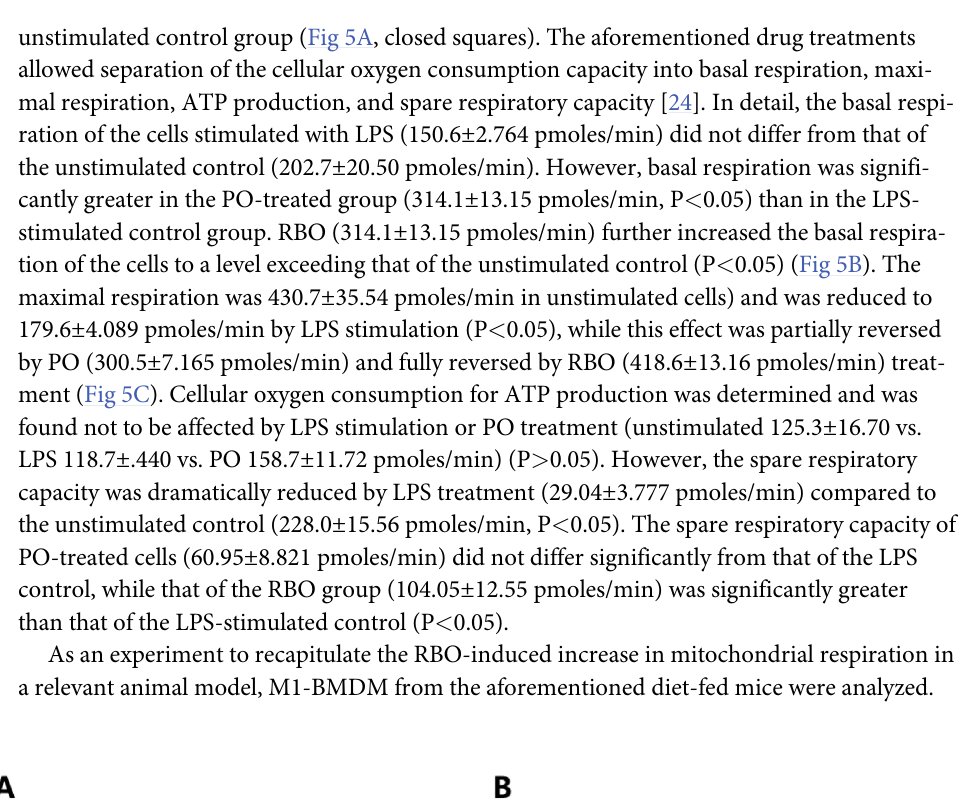
Fig 2. Cytokine production by M1-polarized BMDM following dietary intervention with an AIN-76A-based diet containing either CO, PO, or RBO for 4 wks. Data are presented as mean ± SEM (n = 7–8). Values with different letters are statistically significant at p < 0.05 within the panel. (CO, corn oil; PO, palm oil; RBO, rice bran oil).